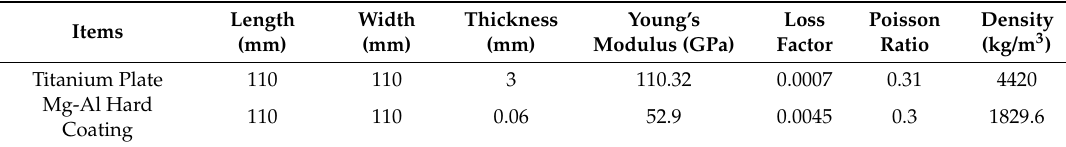
Table 1. The geometry and material parameters of substrate and hard coating.